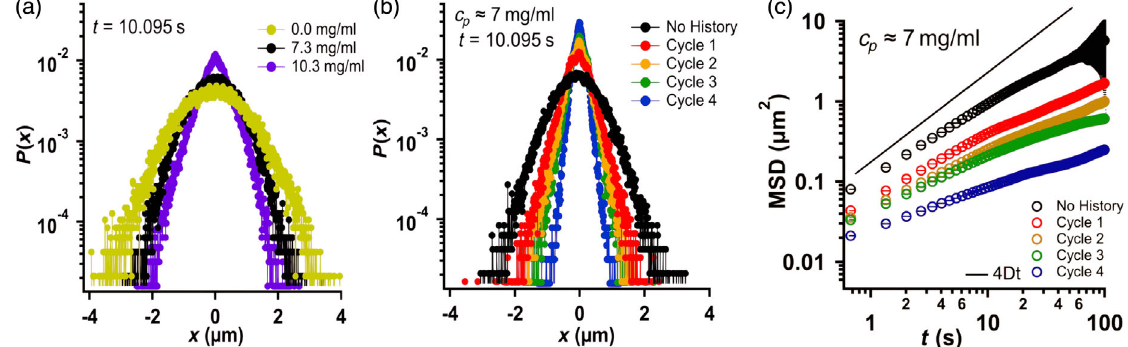
FIG. 6. From Gaussian to non-Gaussian. (a) In the absence of the field, the probability distribution of displacements (plotted for time ¼ 10 . 3 mg = ml. (b),(c) t ¼ 10 . 095 s) is Gaussian at low c but becomes increasingly non-Gaussian on approaching the gel regime for c p p ¼ 7 mg = ml and t ¼ 10 . 095 s, the probability distribution of For repeated cycling of the external field as shown in Fig. 5(a), at c p displacement (b) becomes increasingly non-Gaussian, i.e., each subsequent cycle has a more pronounced cusp at zero displacement, and the mean-square displacement (c) increasingly subdiffusive, i.e., the solid line shows diffusive behavior (i.e., MSD ¼ 4 Dt for diffusion coefficient D) which has a slope of unity on a log-log plot, while each subsequent cycle has lower